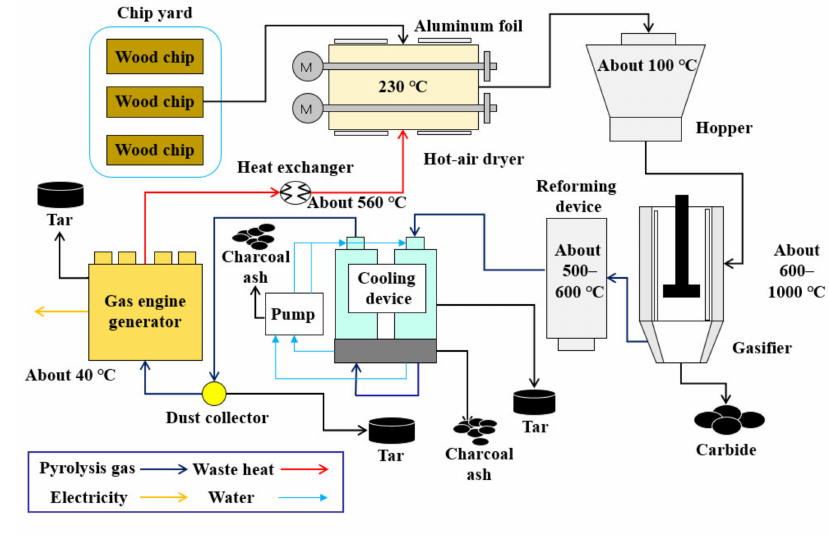
Figure 6. Gasification process flow in a power